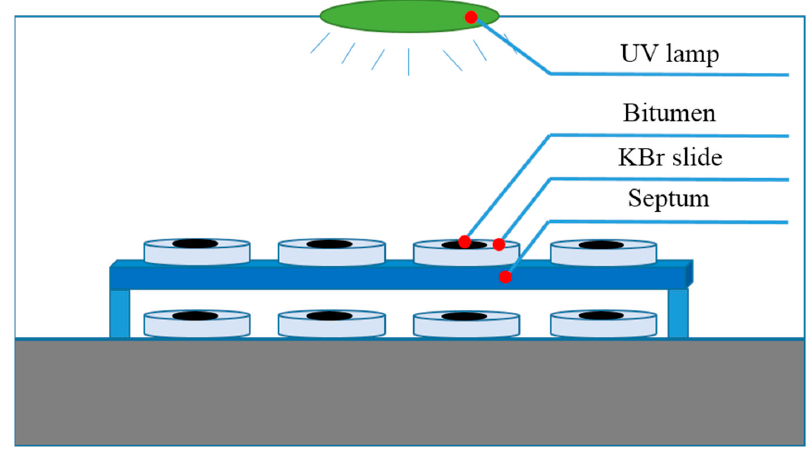
Figure 2. Samples were divided into two parts by septum.